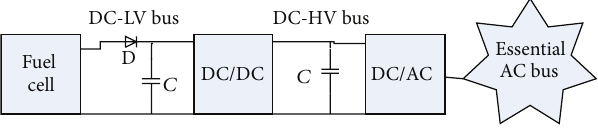
Figure 5: FC connection to AC bus.